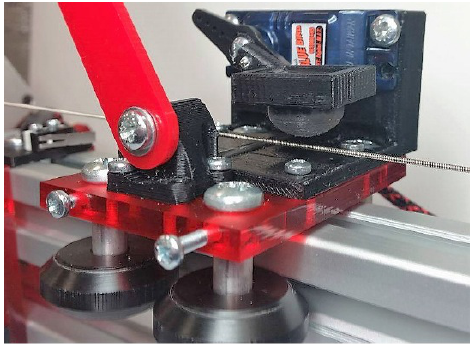
Fig. 9. Group I’s string clamping system (note the compliant